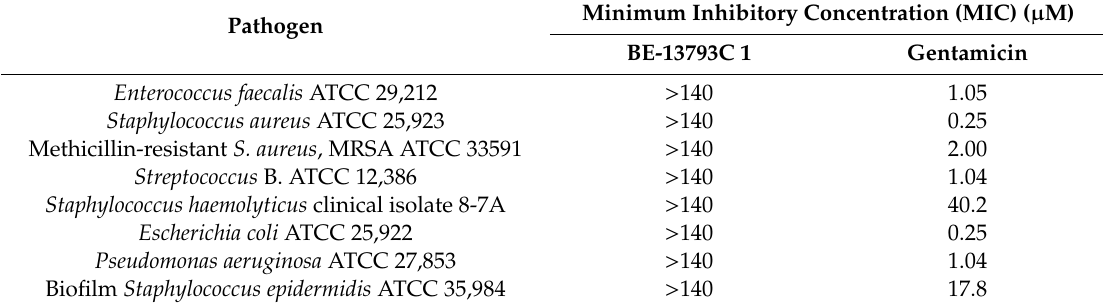
Table 3. Antimicrobial / antibiofilm tests against a panel of bacterial pathogens.